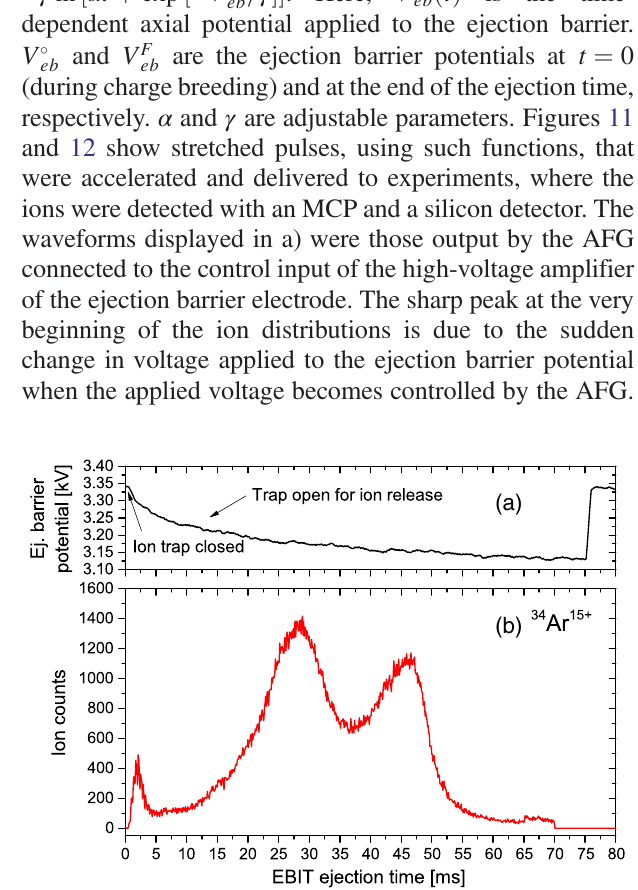
FIG. 12. (a) Logarithmic voltage ramp function used for stretch- ing 34 Ar 15 þ ion pulses ejected from the ReA EBIT, (b) stretched ion time distribution measured with a silicon detector used by an